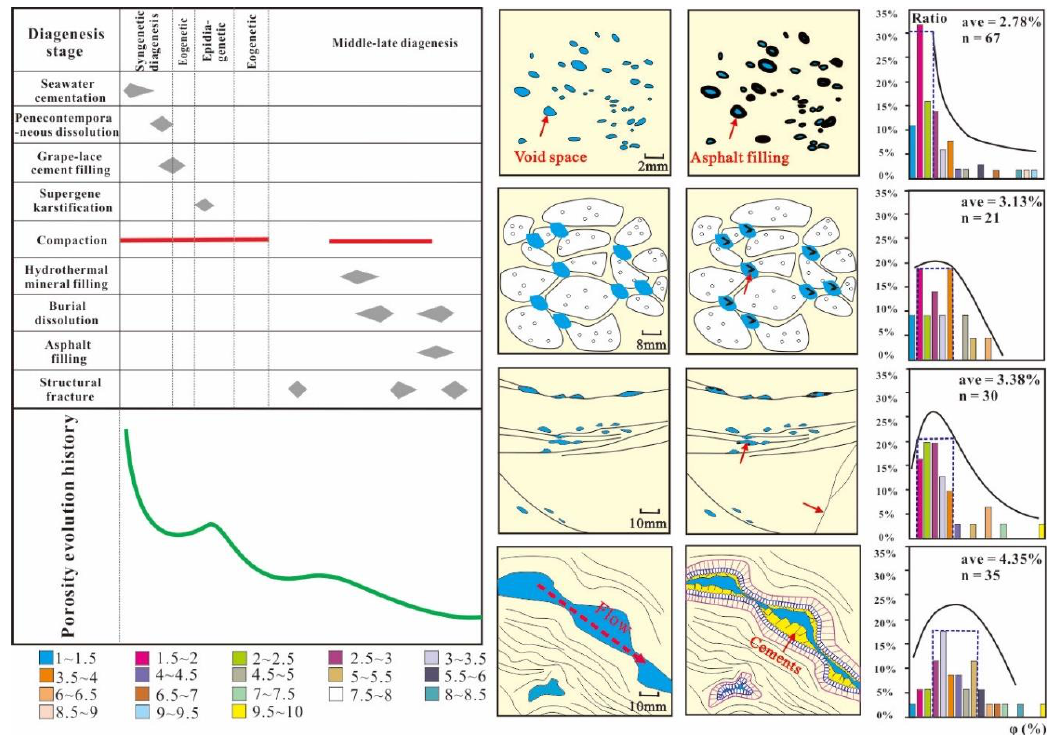
Figure 5. Diagenetic sequence and frequency distribution of porosity of four types (diagenetic sequence was revised from [53]) .